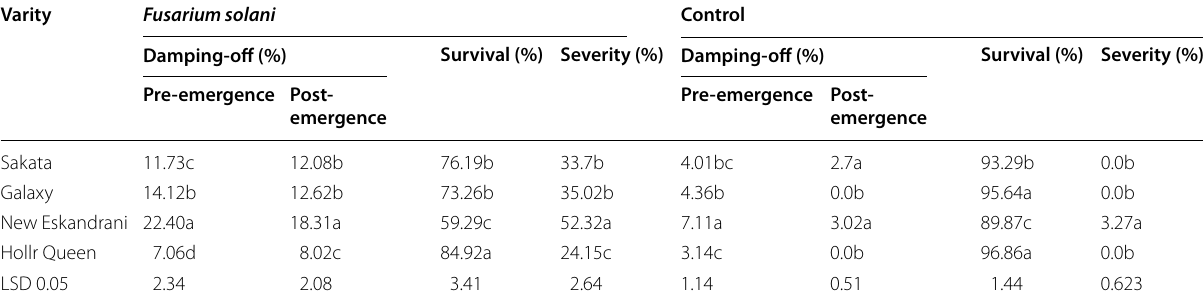
Means in a column followed by the same letters are not significantly different (LSD, P < 0.05)